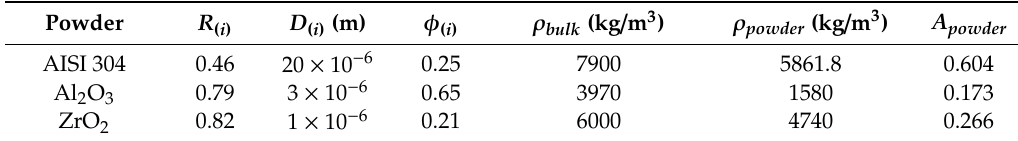
Table 2. Parameters used for obtaining the values of the surface reflectivity ( R ) and absorption coe ffi cient ( A ) of the powder